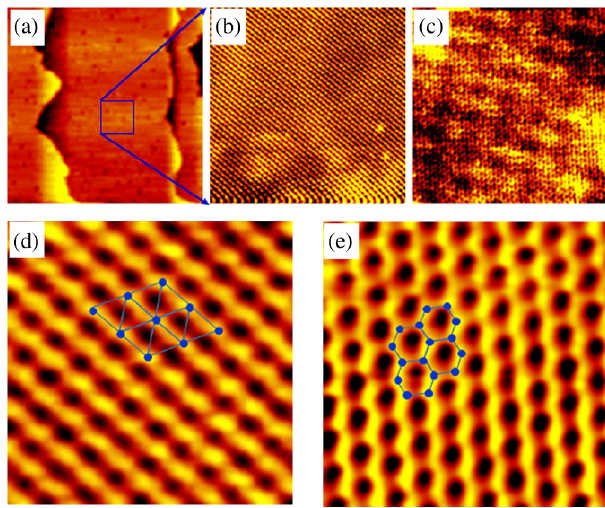
9. STM topography images of a graphene grown on the